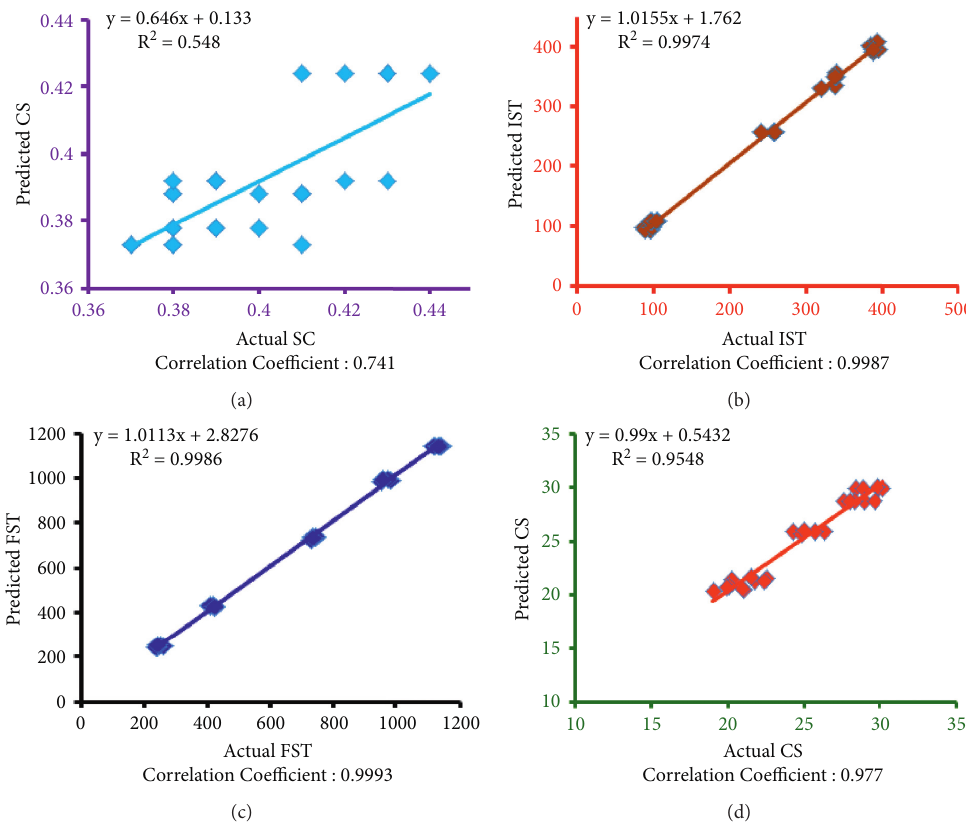
Figure 5: Physical properties of PPC for RHA as a replacement. (a) Standard consistency; (b) initial setting time; (c) final setting time; (d) compressive strength of concrete.